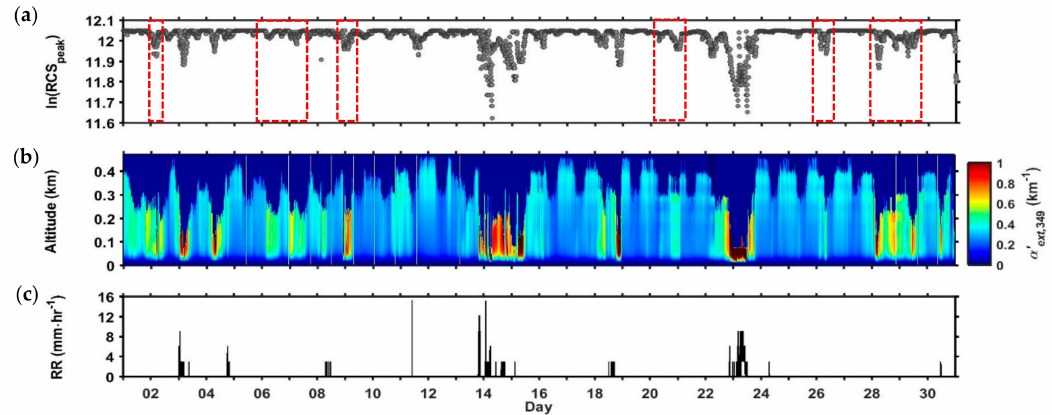
Figure 5. Temporal change of ( a ) lidar signal intensity represented by the RCS peak in natural logarithm scale, ( b ) spatiotemporal variation of the lidar-derived total extinction coe ffi cient, α (cid:48) ( c ) rain rate (RR) during the one-month observation period. The red broken lines in ( a ) indicate the days with high aerosol loading.